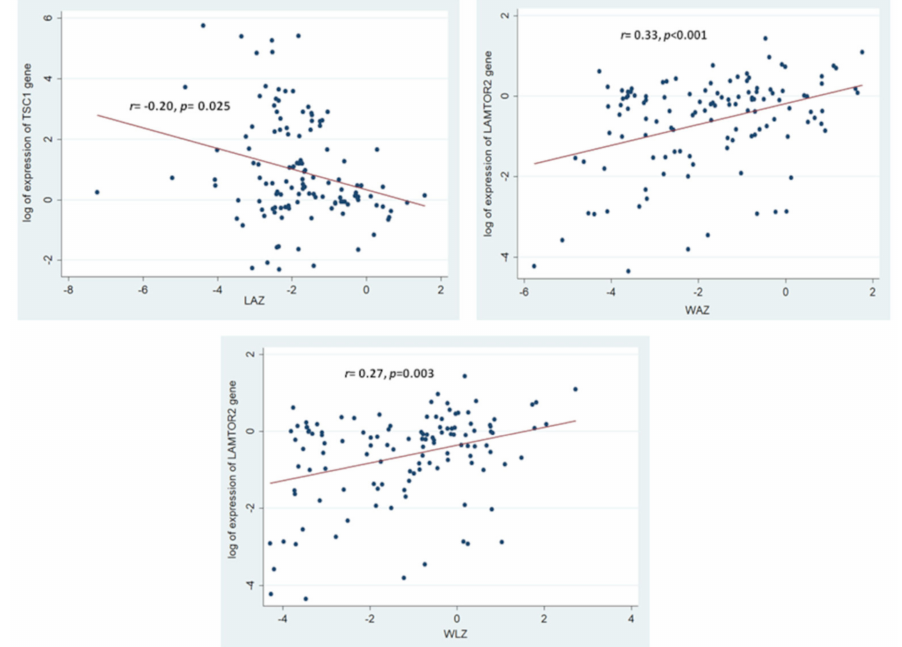
Figure 4. Statistically significant correlations between the expressions of the selected mTOR pathway genes and the anthropometric indices of the study participants. Correlation coefficient and the p -value shown are results of Spearman Rank Correlation between the log of expression of the mTOR pathway genes with the anthropometric indices. The colored circles indicate the individual gene expressions for the respective anthropometric indices of the study